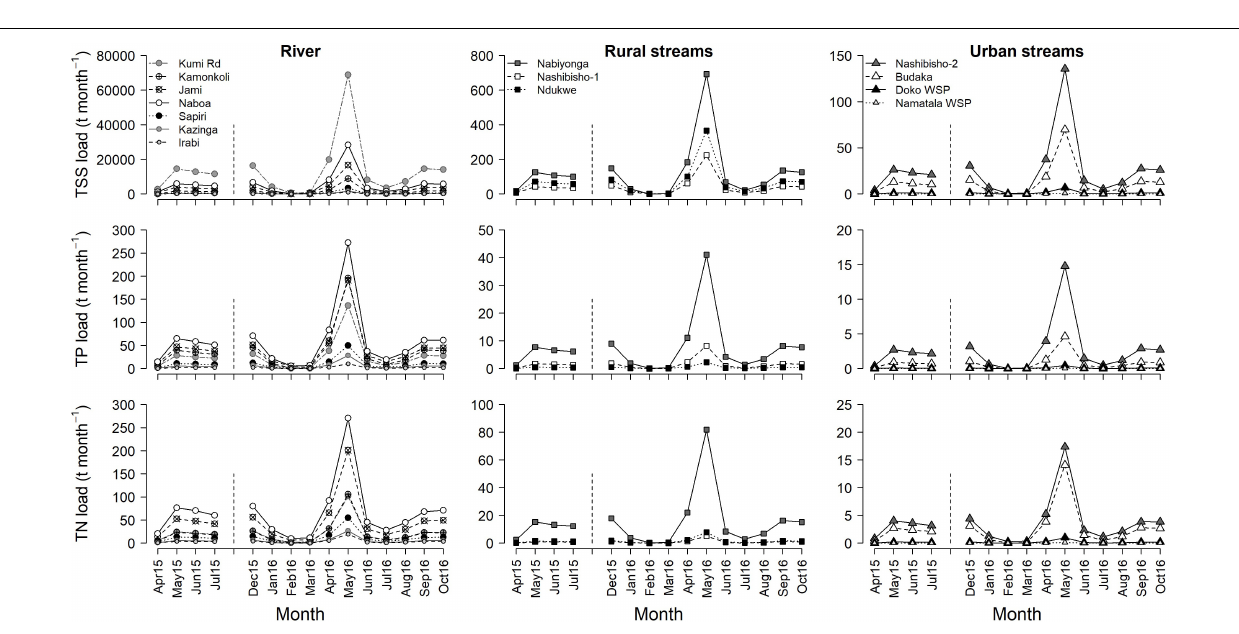
FIGURE 9 | Total suspended solids (TSS), total phosphorus (TP), and total nitrogen (TN) loads (tonnes month − 1 ) from the different streams of Namatala Wetland in the period April 2015–October 2016. For details of load calculations, see text. Loads between August and November 2015 could not be calculated because discharge data from the Kumi Road gauging station were not